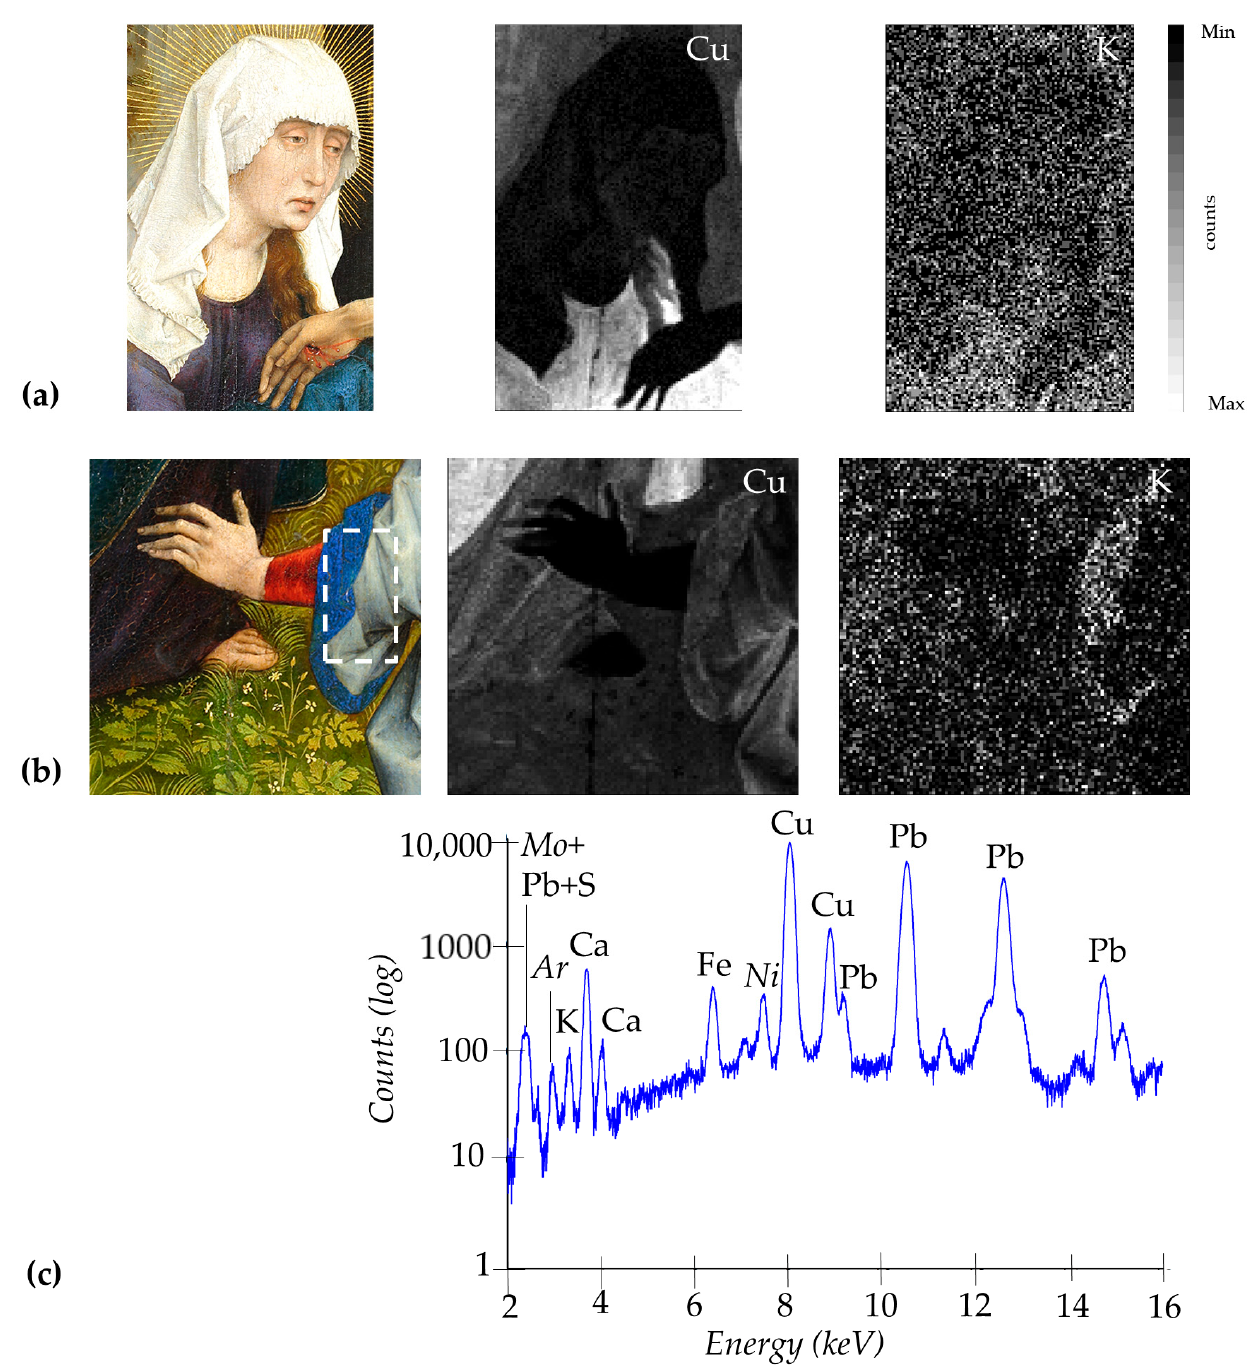
Figure 2. ( a ) Detail of the blue and purple Virgin’s robe, with relative Cu(K α ) and K(K) XRF maps; ( b ) detail of Magdalene’s robe (with purple and blue Virgin’s robe on the back), with relative Cu(K α ) and K(K) XRF maps; ( c ) spectrum of the blue sleeve of Mary Magdalene (relative to the dashed area in detail ( b )). Detected Ni is due to impurities in the X-ray tube, Mo is due to the X-ray tube anode, and Ar is due to the air path.